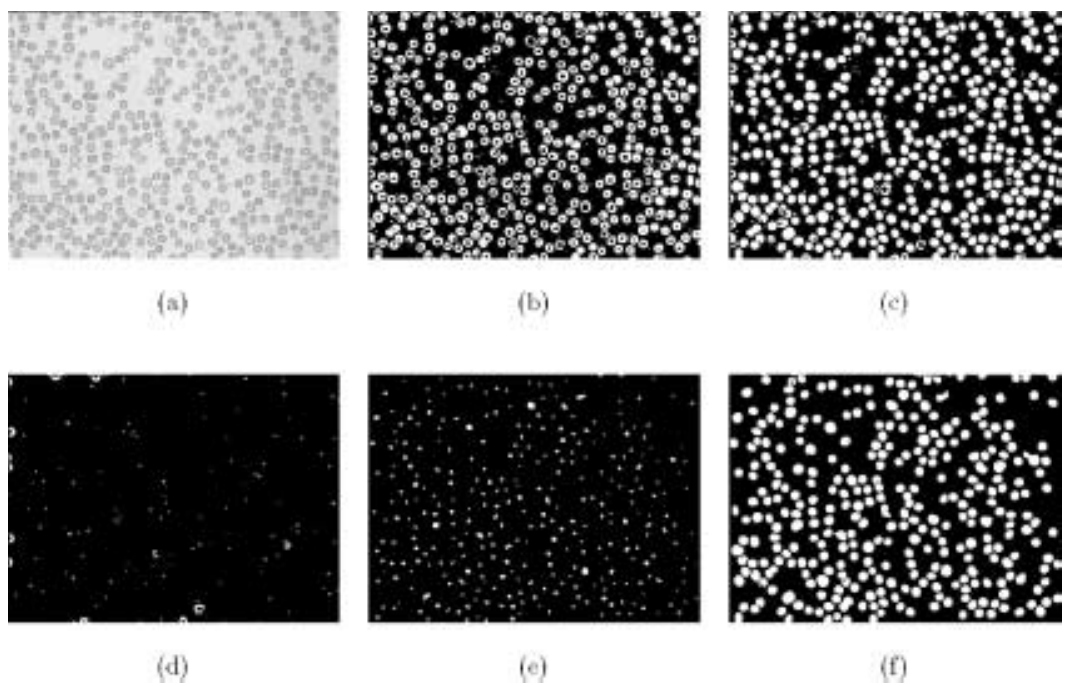
Fig. 6. Cell image analysis algorithm ( × 25): (a) Filtered green component of color image. (b) Binary image after thresholding. (c) Binary mask of cells. (d) Binary mask of platelets and artefacts. (e) Binary mask of centers. (f) Binary mask of cells with center. I pl = I cl − I cl2